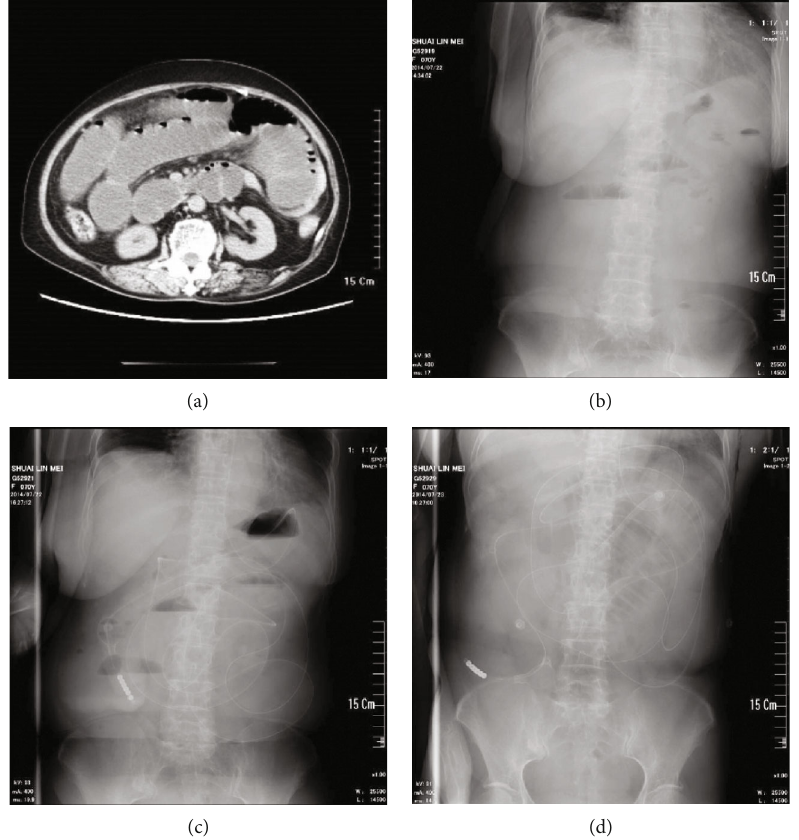
Figure 3: Presentative abdominal X-ray plain fi lms of DIT procedure. (a, b) Before intubation, there were lots of gas-liquid levels, and the proximal intestinal canal dilated obviously. (c) The patient was treated with the DIT procedure, and the intubation depth was up to 265cm. (d) 24 hours after intubation, the gas-liquid levels had almost